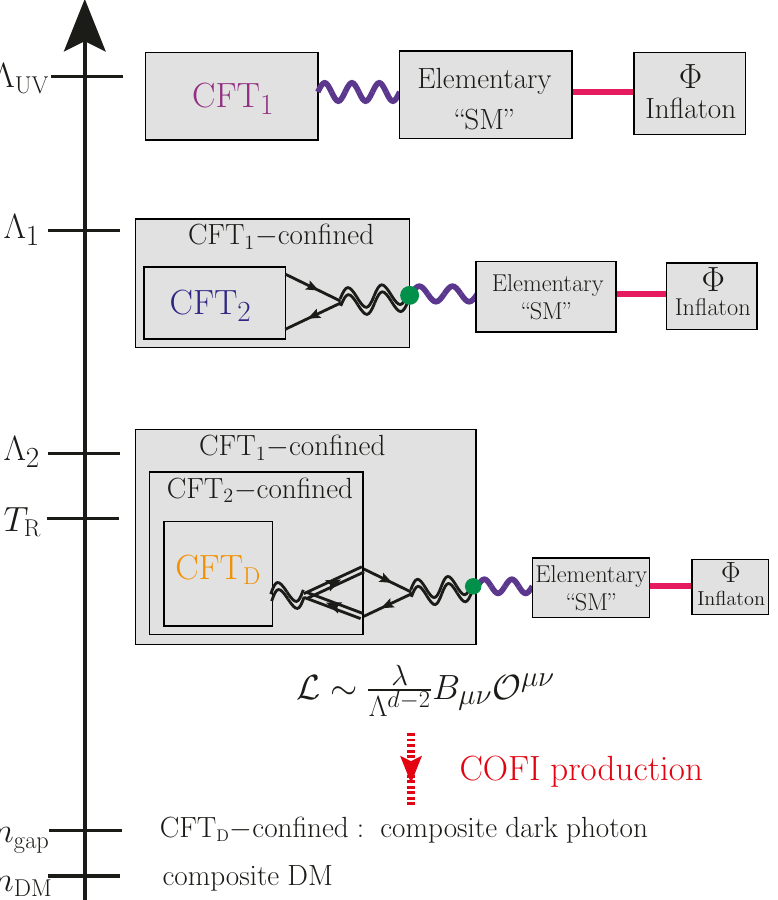
Figure 1 . Our theoretical setup and its RG evolution. Cascade of confinement results in small effective coupling between the SM and dark CFT and asymmetric